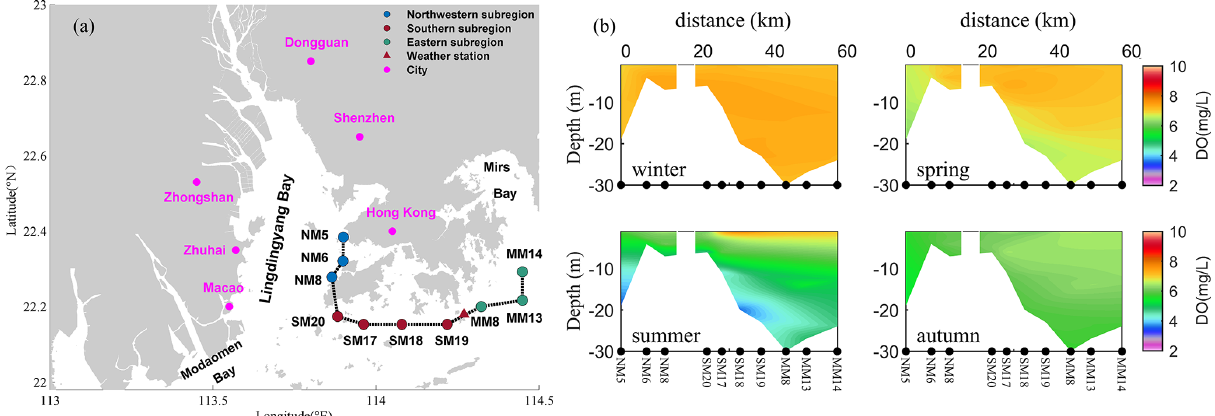
Figure 1. (a) Map of the Pearl River Estuary (PRE) and monitoring stations in the coastal waters off Hong Kong. Note that the blue, red, green dots represent stations in the northwestern, southern, eastern subregions of Hong Kong, respectively. The red triangle denotes the location of the automatic weather station on Waglan Island and the purple dots indicate the location of cities in the Guangdong–Hong Kong– Macao Greater Bay Area. (b) Four subgraphs showing the vertical distributions of mean DO concentrations in winter (December,